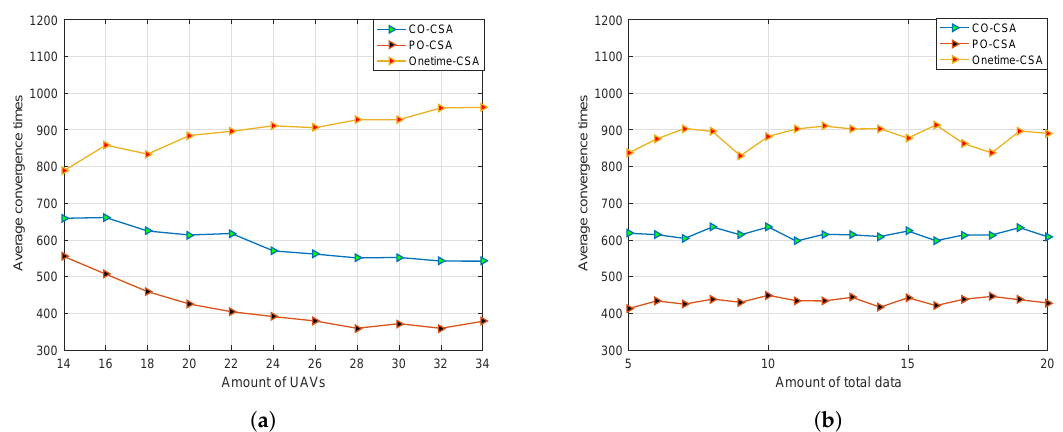
Figure 6. The average convergence times of different numbers of users and data with different methods. ( a ) The average convergence times considering UAV amount. ( b ) The total data throughout considering border length of